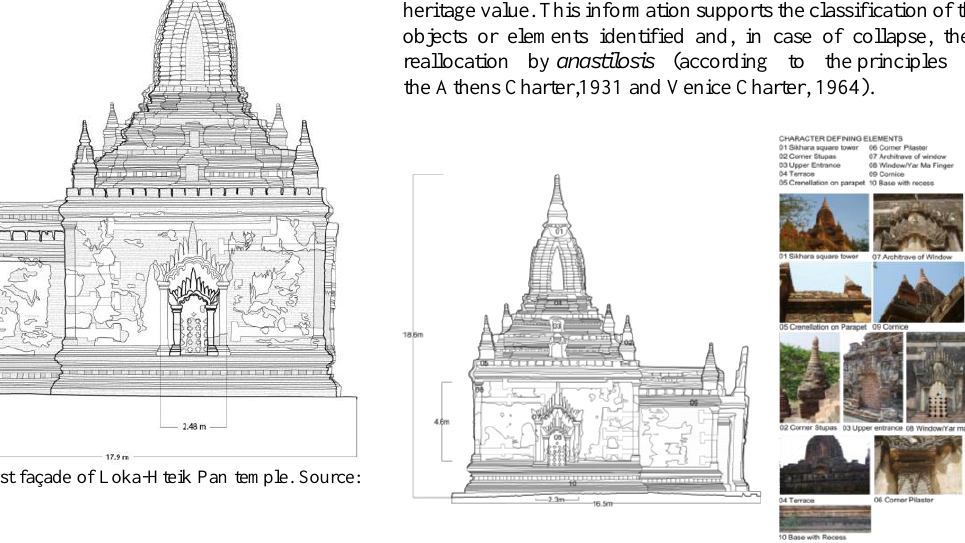
Figure 14: Example of the character defining element analysis of the West façade of the Loka Loka-Hteik Pan temple. Source: Davide